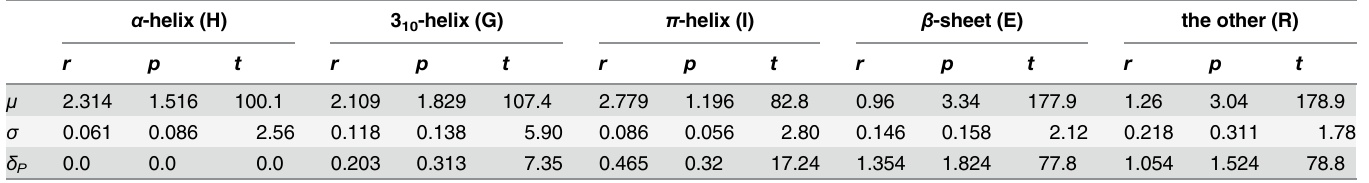
Table 1. The normal distribution parameters ( μ , σ ) for r , p , t . The residues have been divided into five groups (H, G, I, E, R) based on the secondary struc- ture elements assigned by DSSP . The last row ( δ P ) shows the difference in μ between H and the other four groups. The unit for both r , p is Å while t is in degree. α -helix (H) 3 10 -helix